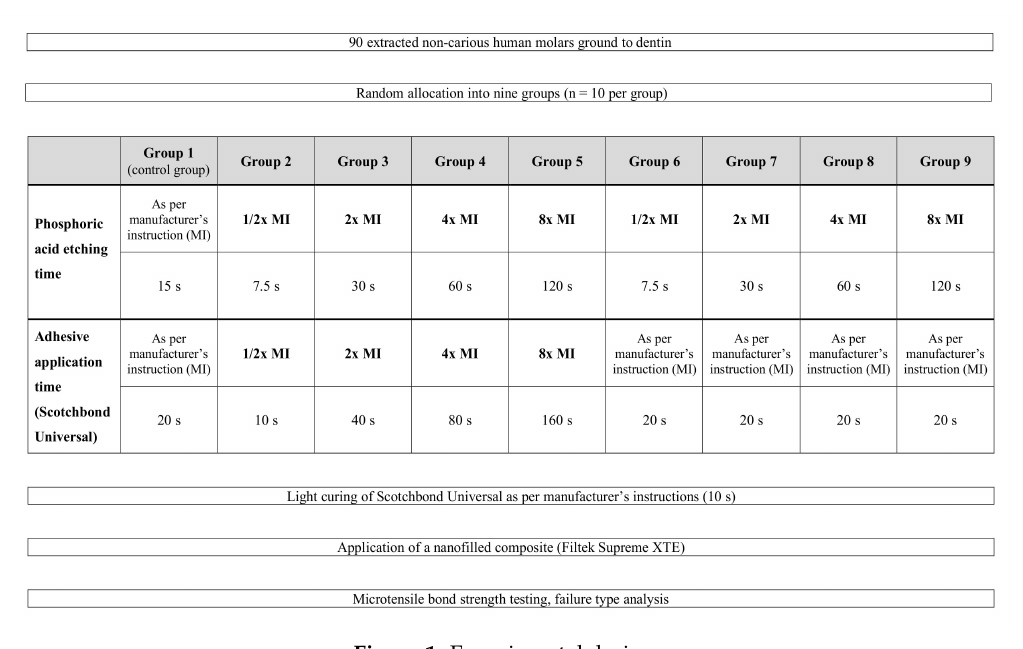
Figure 1. Experimental design. Table 1. Manufacturers’ information about the main materials used in the present